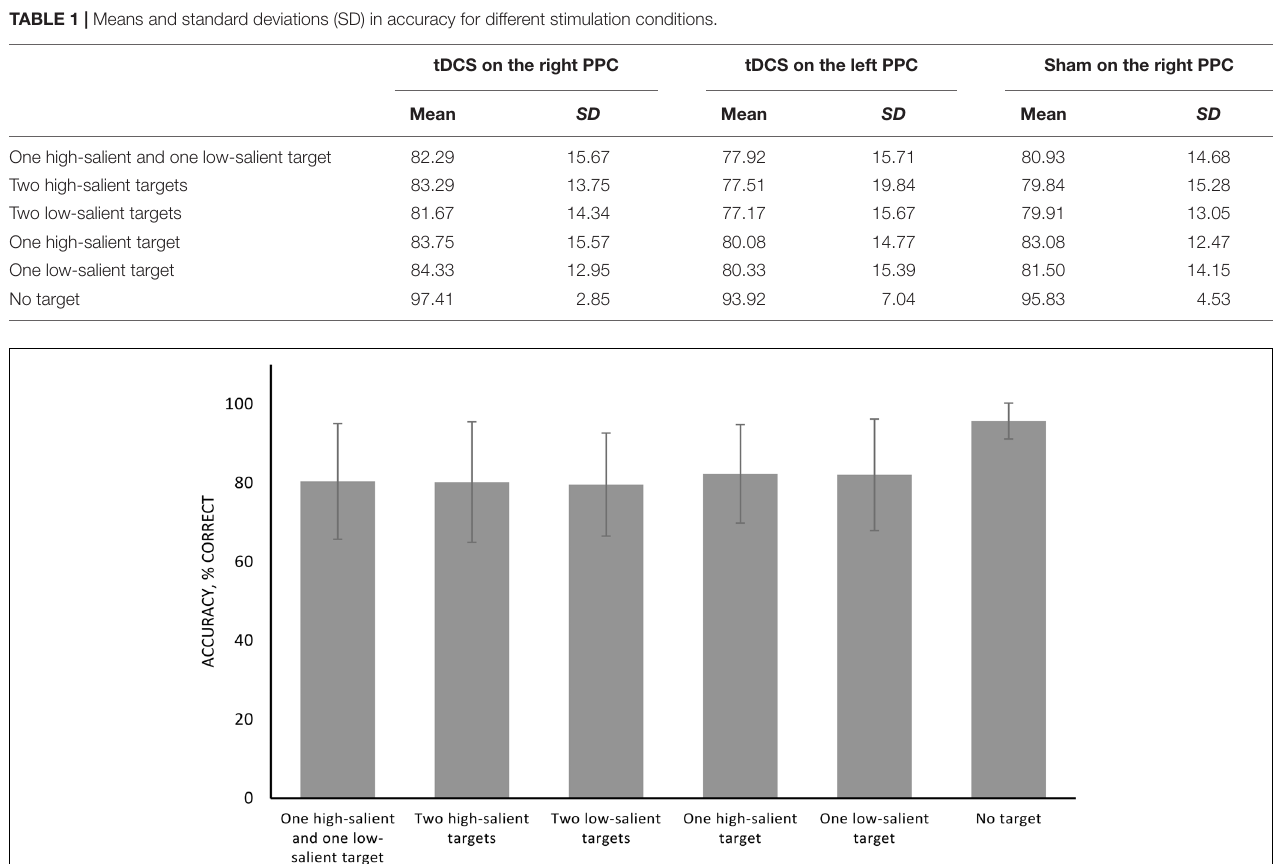
FIGURE 2 | Accuracy (percentage correct) collapsing different stimulation conditions. Error bars represent standard error of the mean.